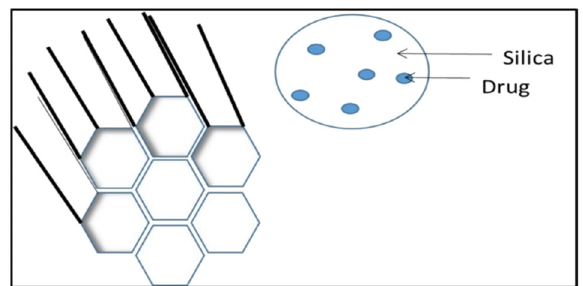
Fig. 4 Silica nanoparticle-based delivery system for